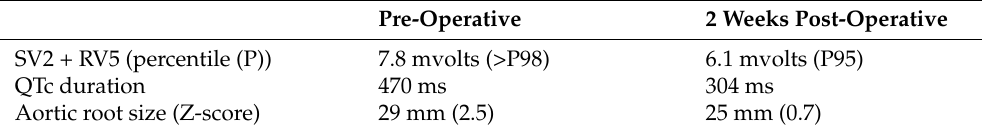
Table 1. Comparison of ECG and echocardiographic parameters measured before and after the operation. The sum of S- and R-wave amplitudes measured respectively in chest leads V2 and V5 and the corresponding percentile value for age were used as diagnostic criteria of left ventricular hypertrophy according to [6]. QTc duration was assessed according to Bazzett’s formula and the Z-score of the diameter of the aortic root according to